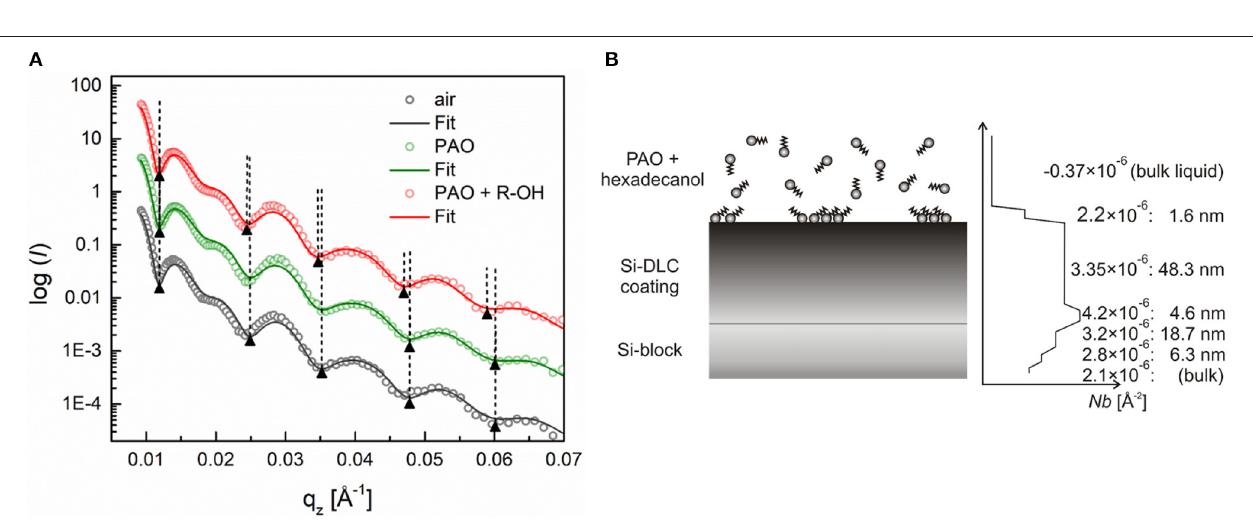
FIGURE 7 | (A) Neutron reflectivity profiles (dots) and best fits (continuous lines) for an a-C:H:Si coating measured in pure PAO oil and a 0.7 wt.% solution of hexadecanol, (B) Schematic of the additive adsorption on an a-C:H:Si DLC coating and the SLD profile extracted from the fitted curve. Adapted from Kalin et al.